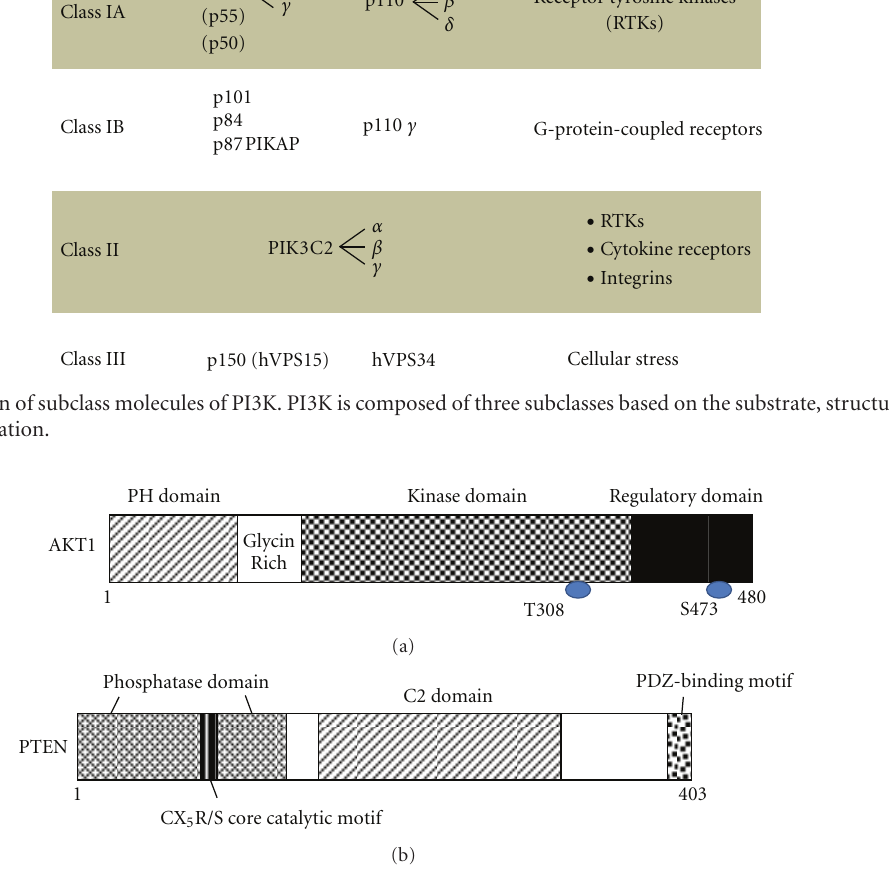
Figure 3: Schematic structures of AKT1 (a) and PTEN (b) protein. The predicted consensual domain structures for each protein are depicted. PH domain: pleckstrin homology domain; C2 domain: a protein structural domain involved in targeting proteins to cell membranes; PDZ: a common structural domain in signaling proteins (PSD95, Dlg, ZO-1, etc.).